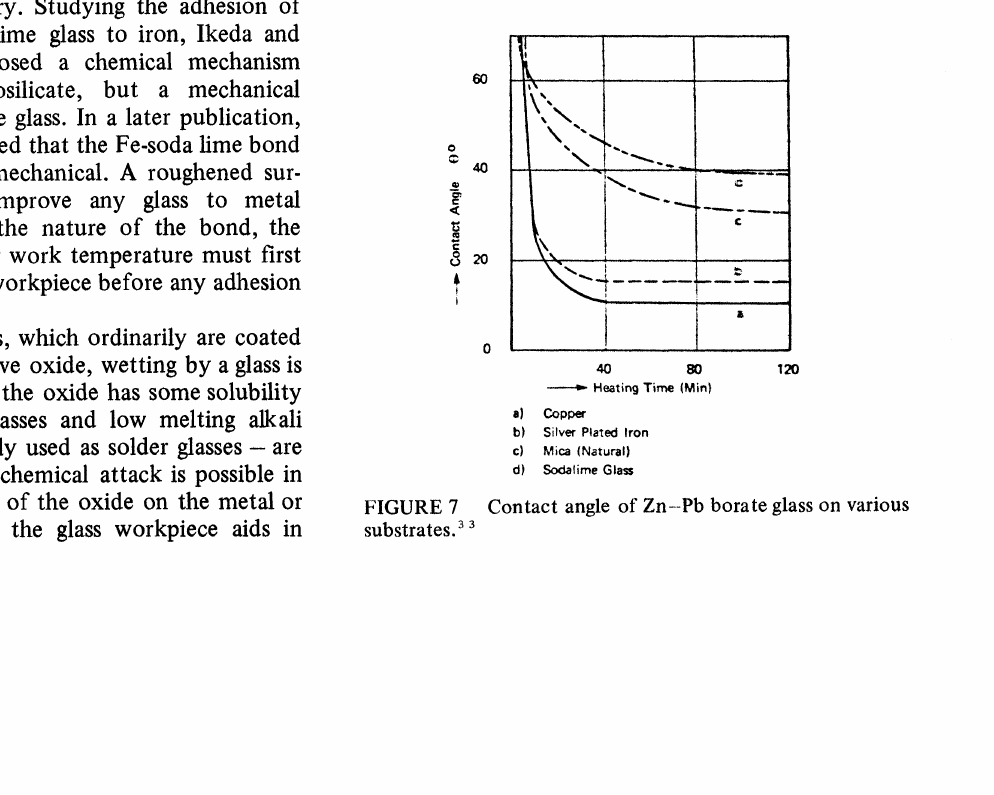
Contact angle of Zn--Pb borate glass on